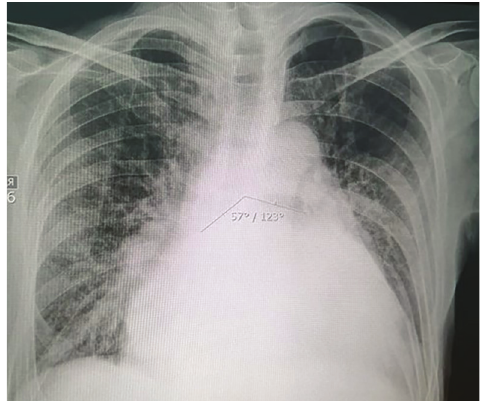
Figure 1 - Chest X - ray. Shift of the Carina angle to 123 degrees